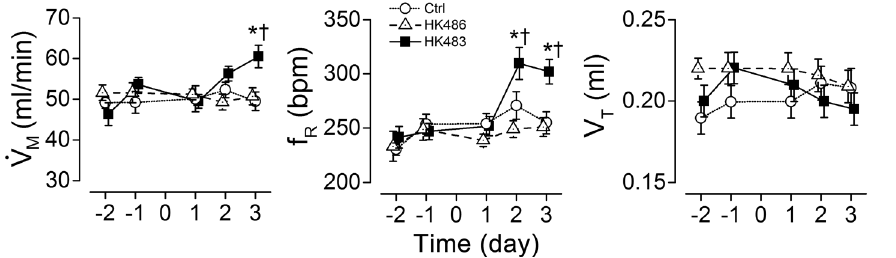
Fig 2. Comparison of viral infection effects on baseline V (cid:1) M among Ctrl, HK483, and HK486 mice. V (cid:1)